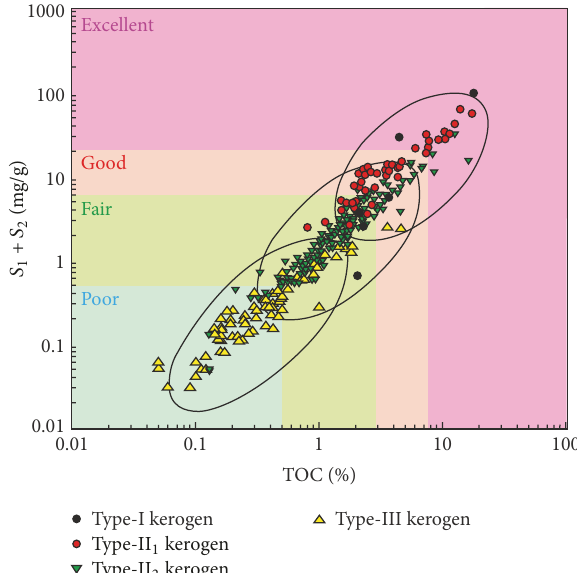
Figure 6: The relationship between the hydrocarbon generation potential ( 𝑆 1 + 𝑆 2 ) and the total organic carbon (TOC) of the Eocene Wenchang and Enping source rocks developed during the continental rift stage in the Huizhou Sag.